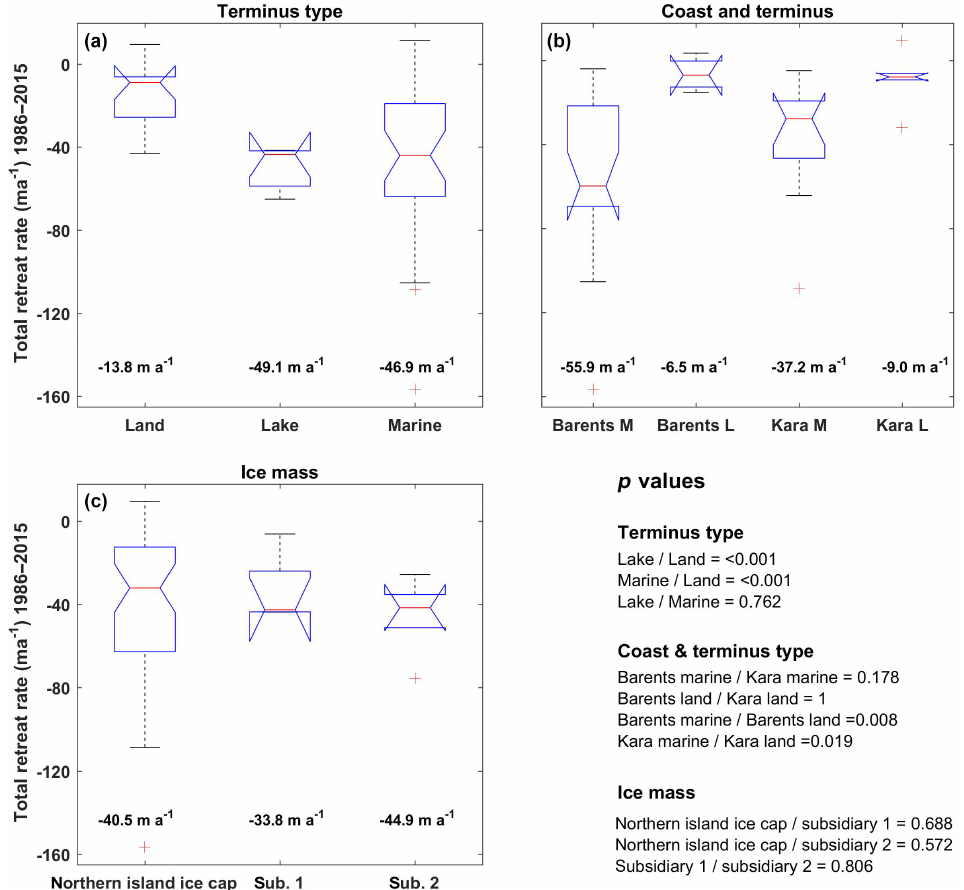
Figure 2. Box plots and Kruskal–Wallis test results for different glacier terminus settings for (a) terminus type; (b) coast and terminus: L stands for land-terminating, and m for marine-terminating; and (c) ice mass, specifically the northern island ice cap and subsidiary ice fields 1 and 2. See Fig. 1 for ice mass locations. In all cases, total retreat rate (1986–2015) is used to test for significant differences between the classes. Mean total retreat rates for each class are given on each plot, below the associated box plot. For each box plot, the red central line represents the median; the blue lines represent the upper and lower quartile; red crosses are outliers (a value more than 1.5 times the interquartile range above/below the interquartile values); and the black lines are the whiskers, which extend from the interquartile ranges to the maximum values that are not classed as outliers. P values for each Kruskal–Wallis test are given on the right of the